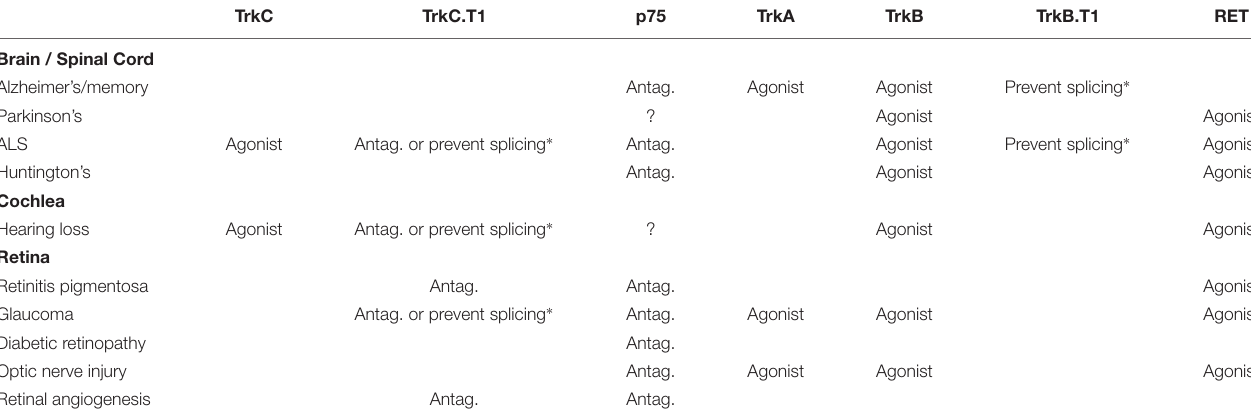
TABLE 1 | Experimental (and in some cases clinical) validation of the indicated receptor targets as “proof-of-concept” in neurodegenerative diseases affecting the CNS.